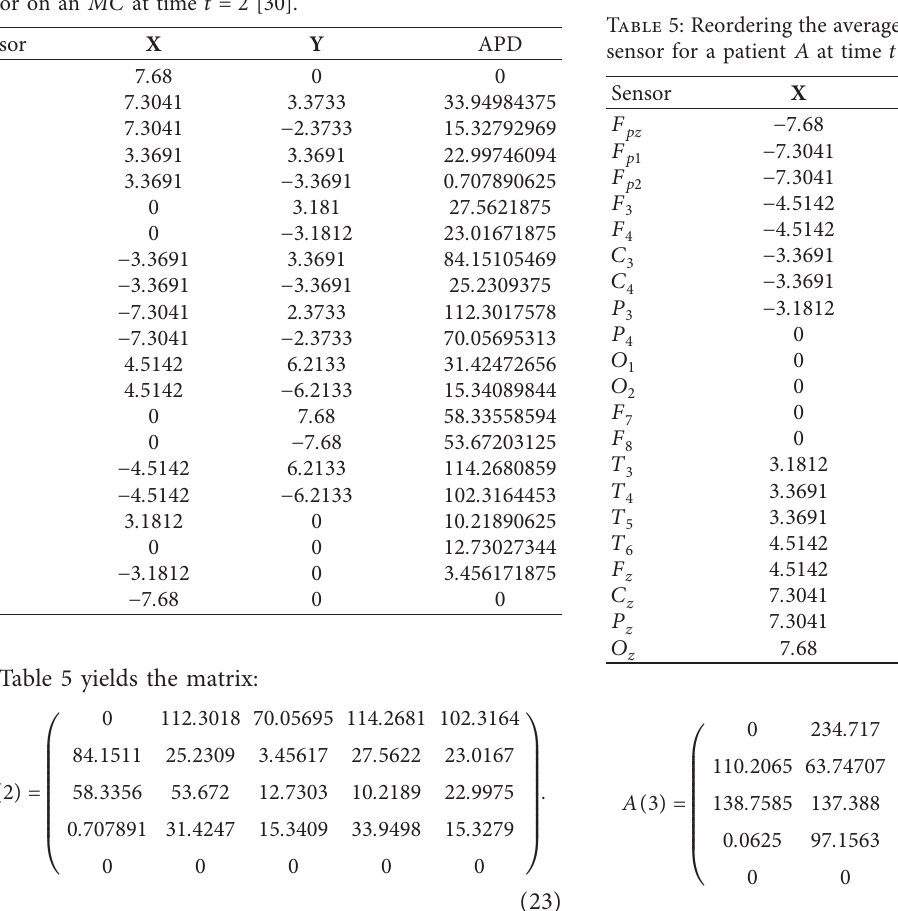
Table 6 yields the matrix: